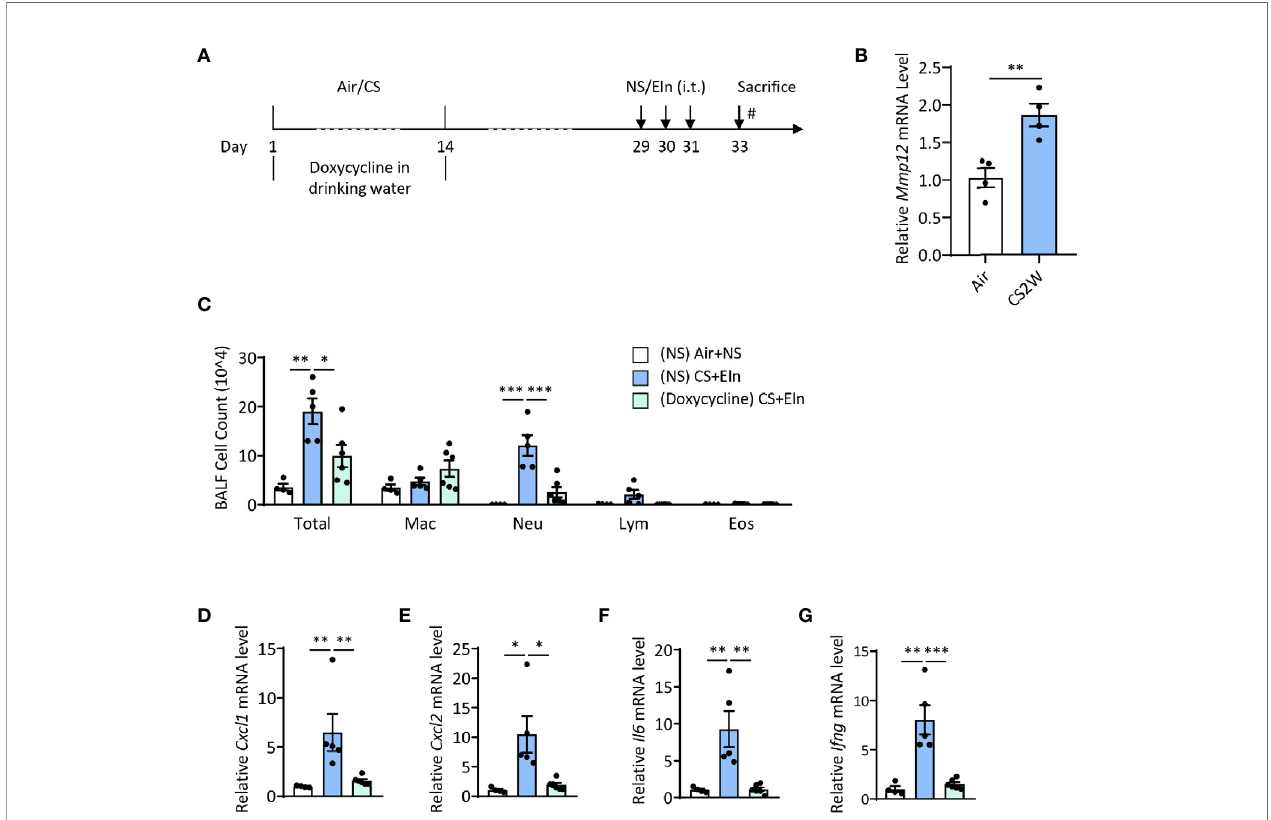
FIGURE 5 | Induction of MMP12 by CS during sensitization phase is critical for the ensuing airway in fl ammation induced by elastin. (A) experimental outline and protocol for doxycycline treatment, mice were fed with doxycycline (2 mg/ml) in drinking water during CS sensitization phase. (B) Expression of Mmp12 mRNA transcripts in mouse BALF cells. (C) In fl ammatory cell counts in the BALF. (D – G) The Cxcl1 , Cxcl2 , Il6 and Ifng mRNA transcripts in lungs. Labeling for all the columns throughout Figure 5 was shown in (C) . Mac: macrophages; Neu: neutrophils; Lym: lymphocytes; Eos: eosinophils. Dox: doxycycline. Throughout, data are representative of 4-6 mice and were replicated in at least 3 independent experiments. Data are presented as mean ± s.e.m. Difference between two groups was identi fi ed using the Student t-test (B) and multiple groups using one-way ANOVA (C – G) . * p < 0.05, ** p < 0.01, *** p <